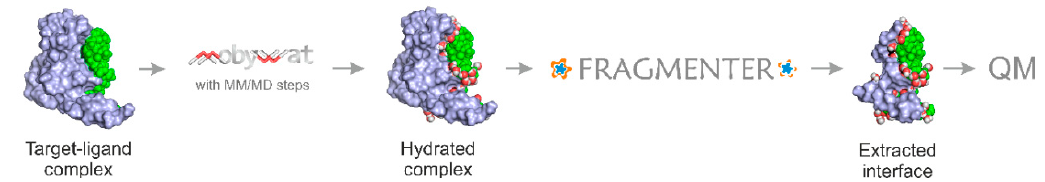
Figure 5. Modeling steps used for preparation of hydrated target-ligand interface for QM calculations shown on the example of System 1jgn. The procedure starts from the complex of the target (grey) and ligand (green) molecules. Program MobyWat [32,46] provides accurate hydration structure with MD-based calculations of positions of water molecules (red and white) in the interface. MobyWat is downloadable free of charge at www.mobywat.com. Finally, Fragmenter, a web service extracts the complex interface with considerably reduced target part for subsequent use in QM calculations. Fragmenter was introduced in the present study and available at www.fragmenter.xyz.